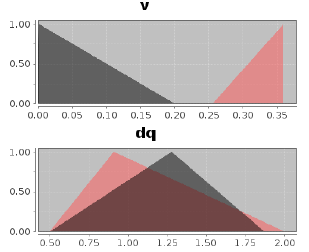
Fig. 11. Membership functions after